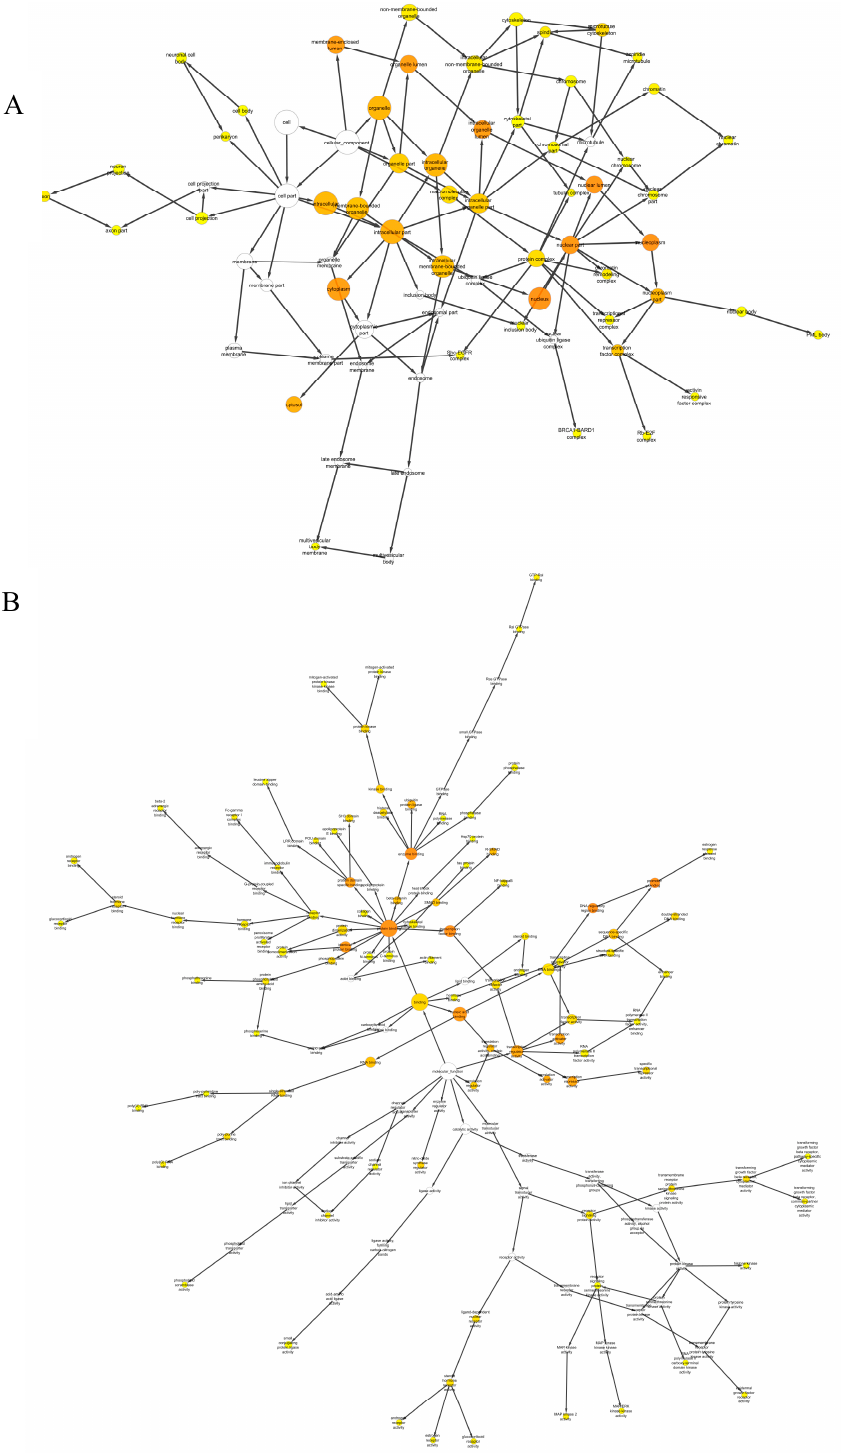
Figure 2. The BiNGO analysis regarding: cellular component and molecular function. ( A ) Map of the cellular component and molecular function associated with the azoospermia small network. Darker nodes refer to the substantial ontologies of the dataset. The majority of the proteins are in the nucleus, cytoplasm and intracellular part; ( B ) In terms of function and biological process, the majority of the proteins are involved in protein binding, and are thereby linked to other protein nodes such as protein domain–specific binding, identical protein binding, SMAD binding, identical protein binding, phosphoproteins binding, β -catenin binding and transcription factor binding.